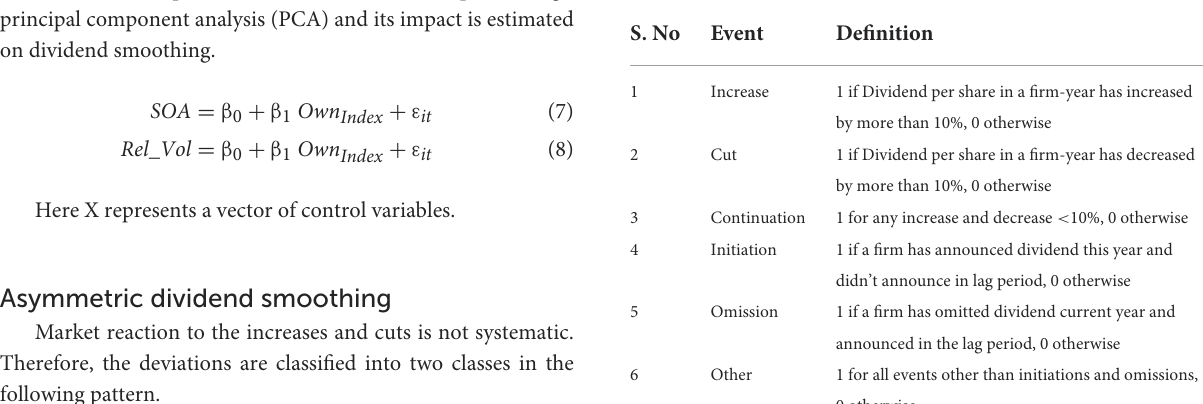
TABLE 2 Definitions of dividend